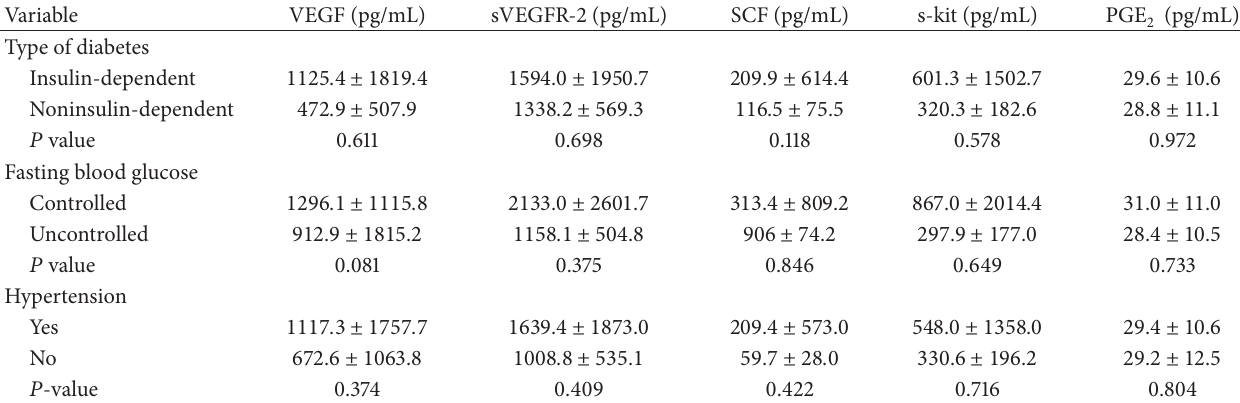
Table 4: Relationship between angiogenic and vasculogenic factors and systemic disease variables.